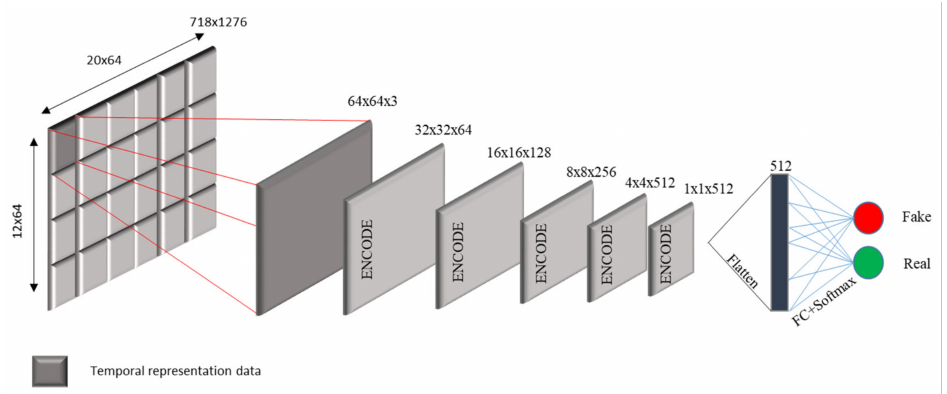
Figure 2. Architecture of the PatchGAN Discriminator of ICGA